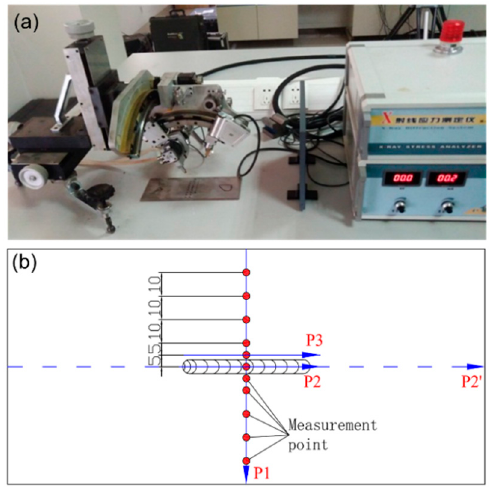
Figure 2. The XRD setup ( a ) and measurement paths and points ( b ).